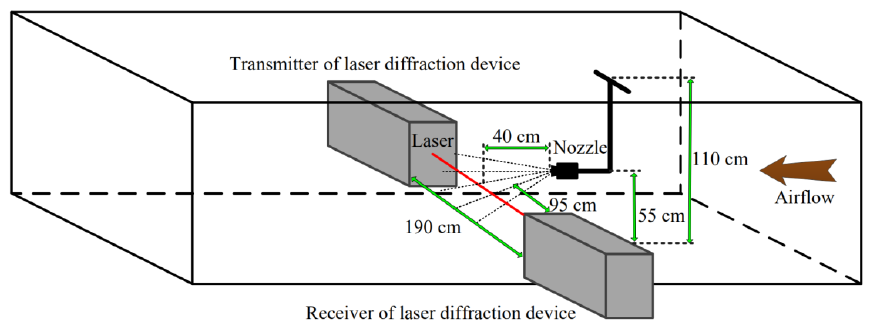
Figure 3. Schematic of the spray test layout.